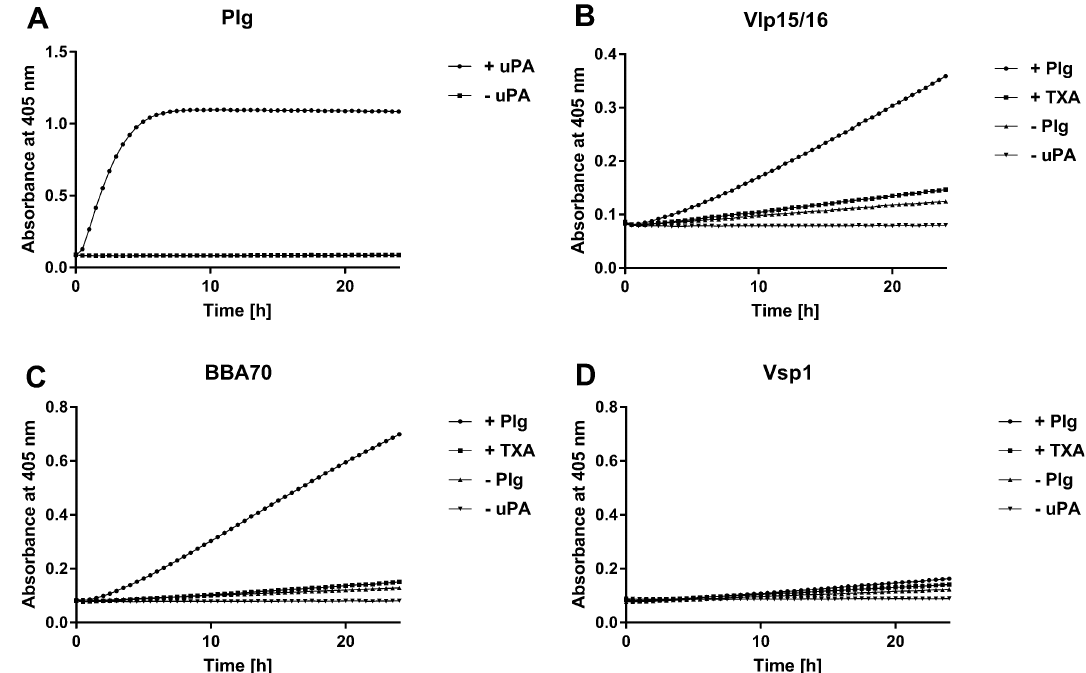
Figure 4. Plasminogen is converted to plasmin by uPA when bound to Vlp15/16. Microtiter plates were either coated with 5 µg/ml of plasminogen (Plg) ( A ) or with 5 µg/ml of purified Vlp15/16 (B) , BBA70 ( C ) or Vsp1 ( D ). The plasminogen-coated wells were then incubated with (filled circle) or without uPA (filled square). The immobilized borrelial proteins were subsequently incubated with 10 µg/ml plasminogen. Following incubation uPA and the chromogenic substrate D-Val-Leu-Lys-p-nitroanilide dihydrochloride (S-2251) was added (filled circle). Control reactions included 50 mM of the lysine analog tranexamic acid (T) (filled square) or omitted plasminogen (filled triangle) or uPA (filled inverted triangle), respectively. Microtiter plates were incubated at RT for 24 h and absorbance at 405 nm was measured at 30 min intervals. At least three